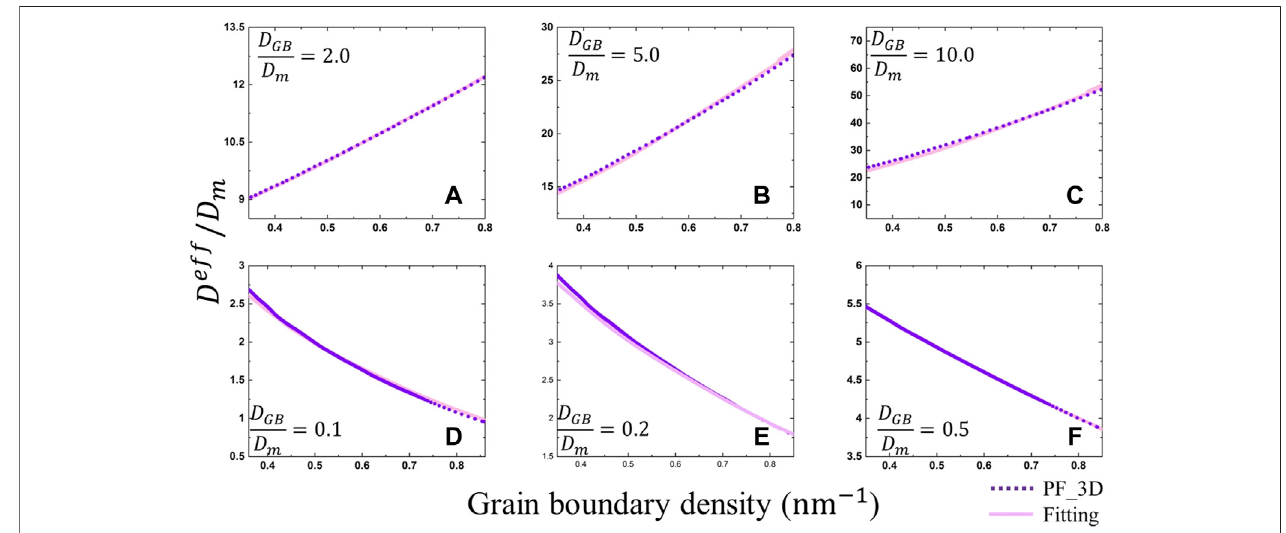
FIGURE 5 | The comparison between the simulated and fi tted effective diffusion coef fi cients of H in 3D polycrystalline W with three diffusion coef fi cient ratios D GB / D m of H are greater than 1.0 (A-C) and less than 1.0 (D-F) . The fi tted 3D data is calculated from the 2D results by using Eqs 30 , 31 . The purple dotted curves represent the simulated results and the pink solid curves represent the results predicted by the fi tting